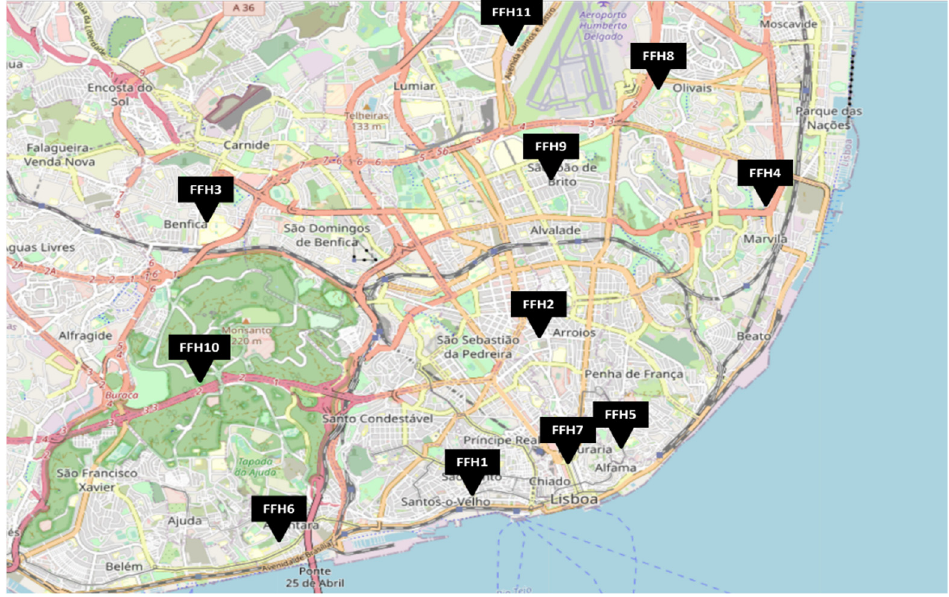
Figure 1. Geographical distribution of the FFH (Firefighter headquarter) assessed.